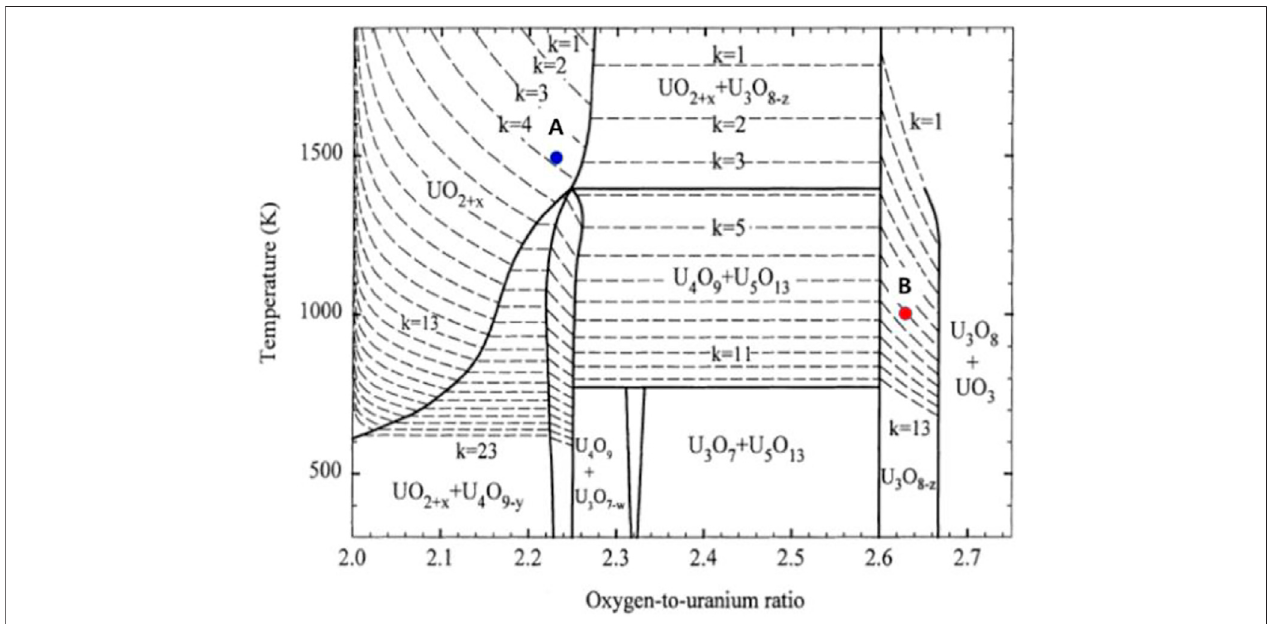
FIGURE3| VariationintheequilibriumoxygenstoichiometrywithtemperatureoftheU – Osysteminpuresteamatmosphere.ThepointsA(bluedot)andB(reddot) indicate the equilibrium oxygen partial pressures of pure steam at 1500 and 1000 K, respectively. The U – O phase diagram is from Ref. (Kim, 2000).